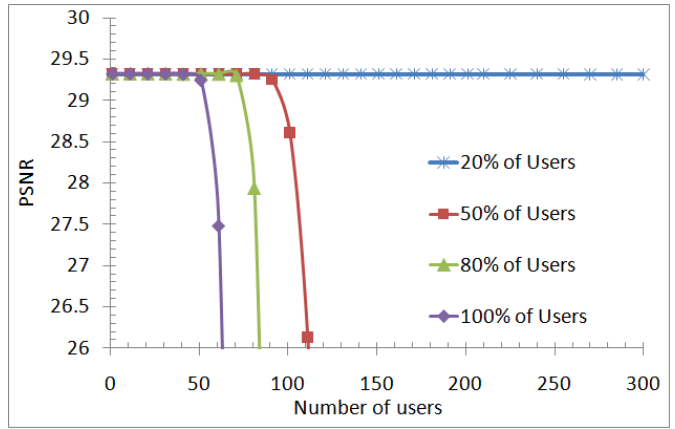
Figure 4. Peak signal-to-noise ratio (PSNR) versus number of users for different classes of users and α = 0.